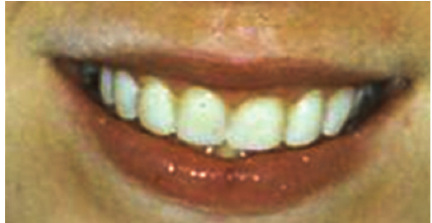
Figure 7: Photograph of reversible “mock up” with direct resin composite on the unetched enamel of just the eroded anterior teeth to allow patient evaluation prior to treatment. This “mock up” or composite simulation was done to check that it met with the patients approval of the proposed changes in appearance. Once it did, the temporary composite ”mock up” was removed and just the anterior eroded teeth were directly bonded freehand at the agreed increased vertical dimension with hybrid resin